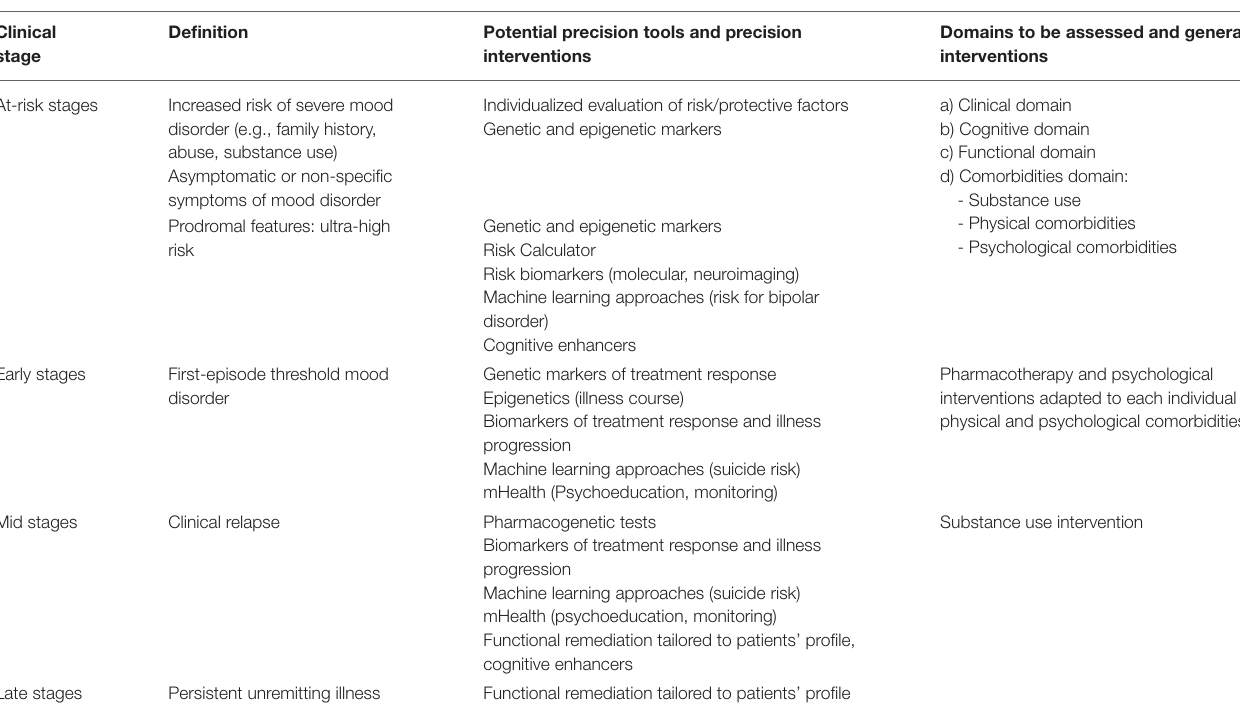
TABLE 2 | Potential precision staging model in bipolar